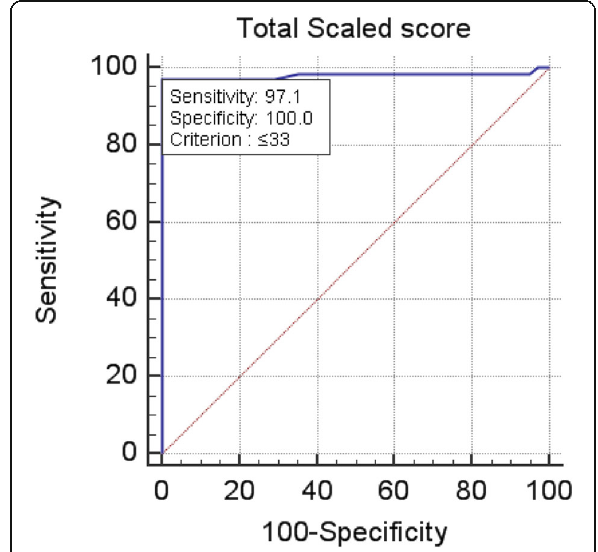
Fig. 3 Area under the (ROC) curve showing that the sum of scaled score is a statistically significant discriminator of dyscalculia from non-dyscalculic